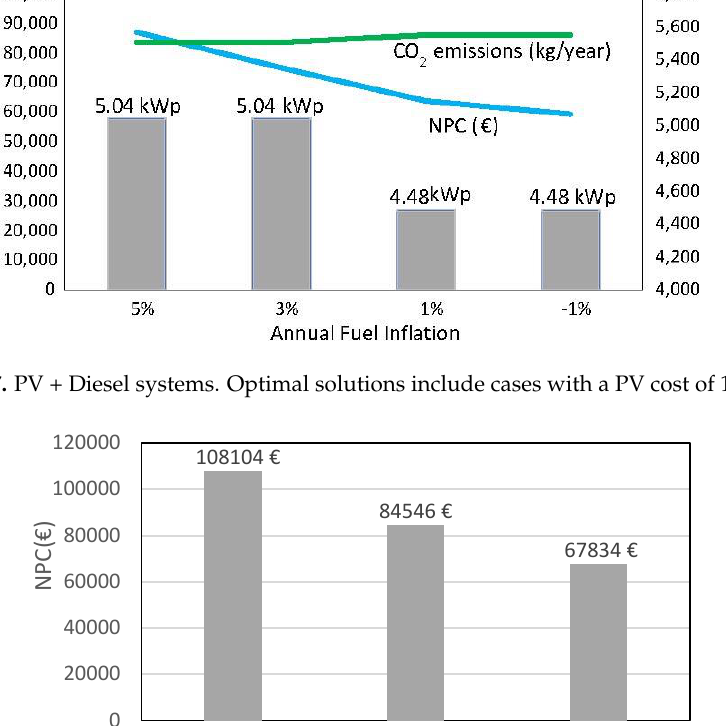
Figure 8. PV + Diesel systems. Effect on the NPC of the interest rate.